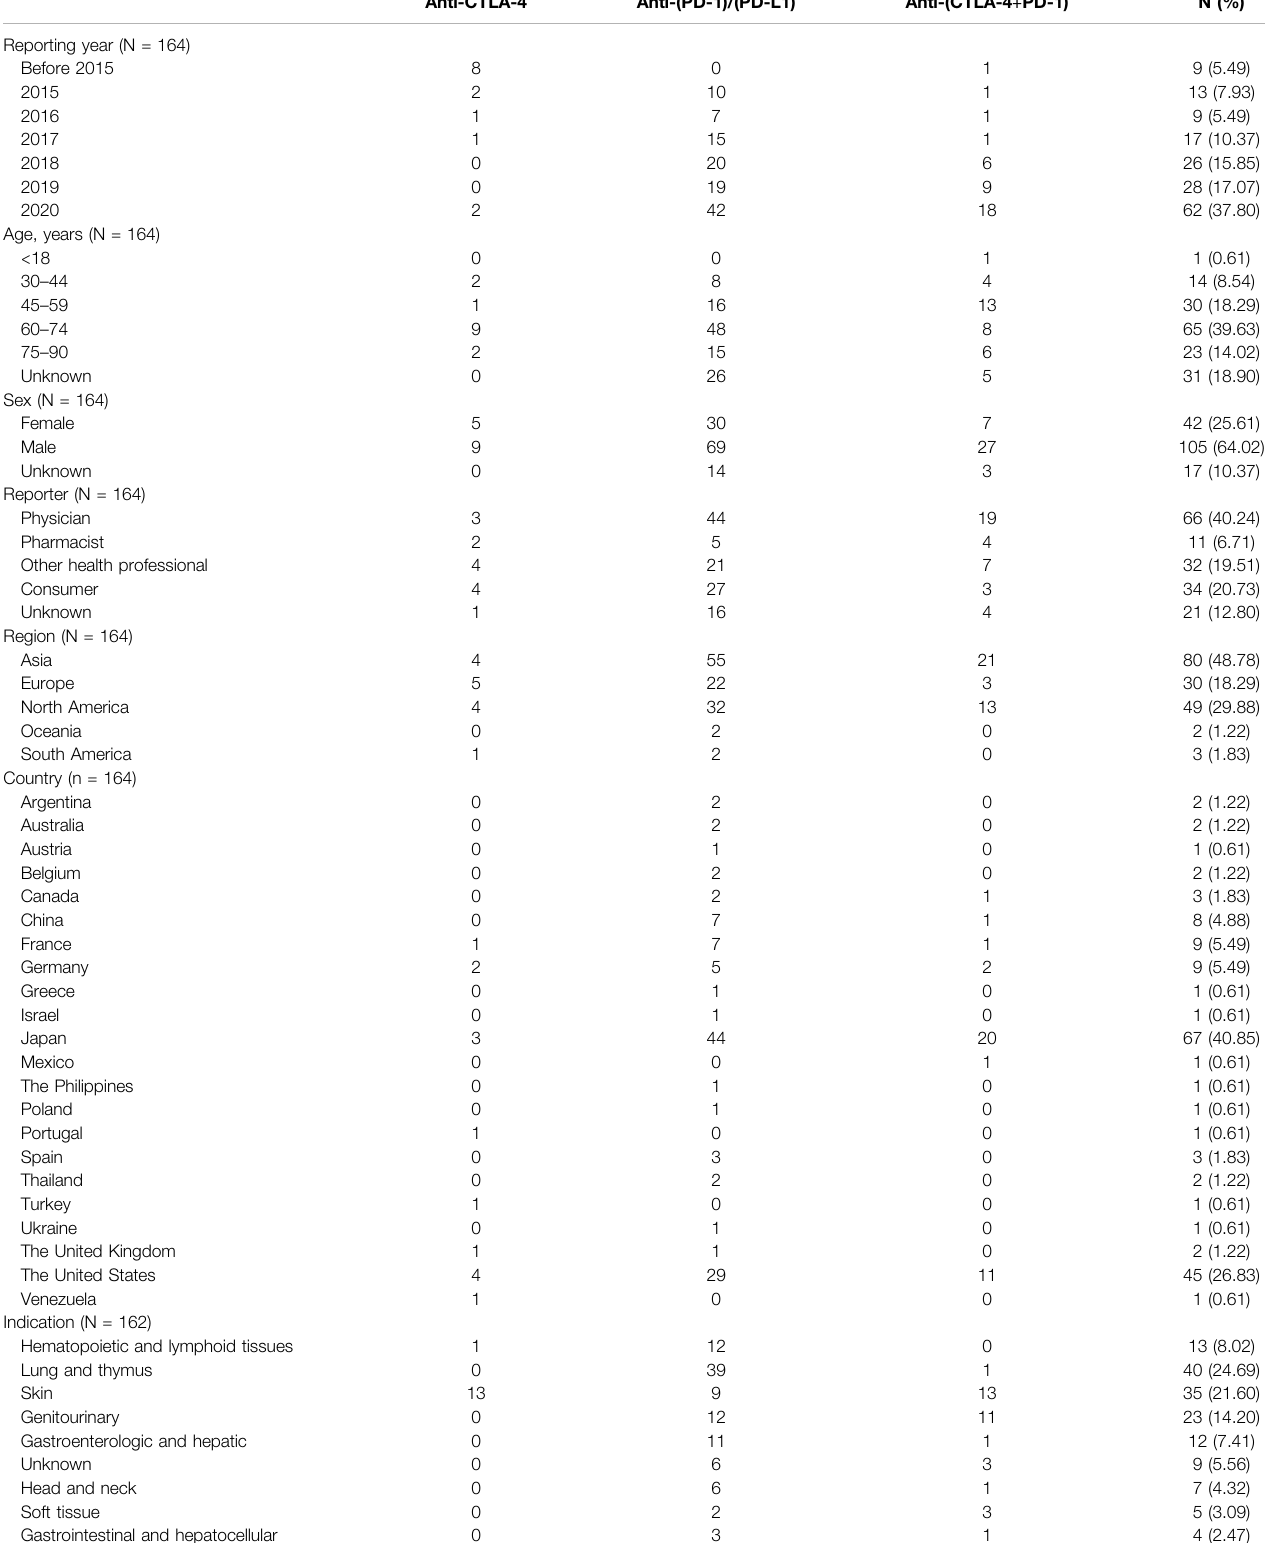
TABLE 3 | Demographic and Clinical Characteristics of TLS in patients receiving treatment with